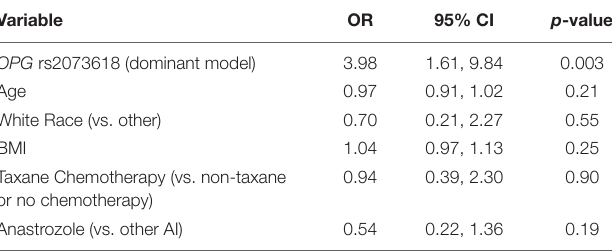
TABLE 3 | Multivariable association of OPG rs2073618 with worsening of joint pain measured on FACT-ES. Variable OR 95% CI p